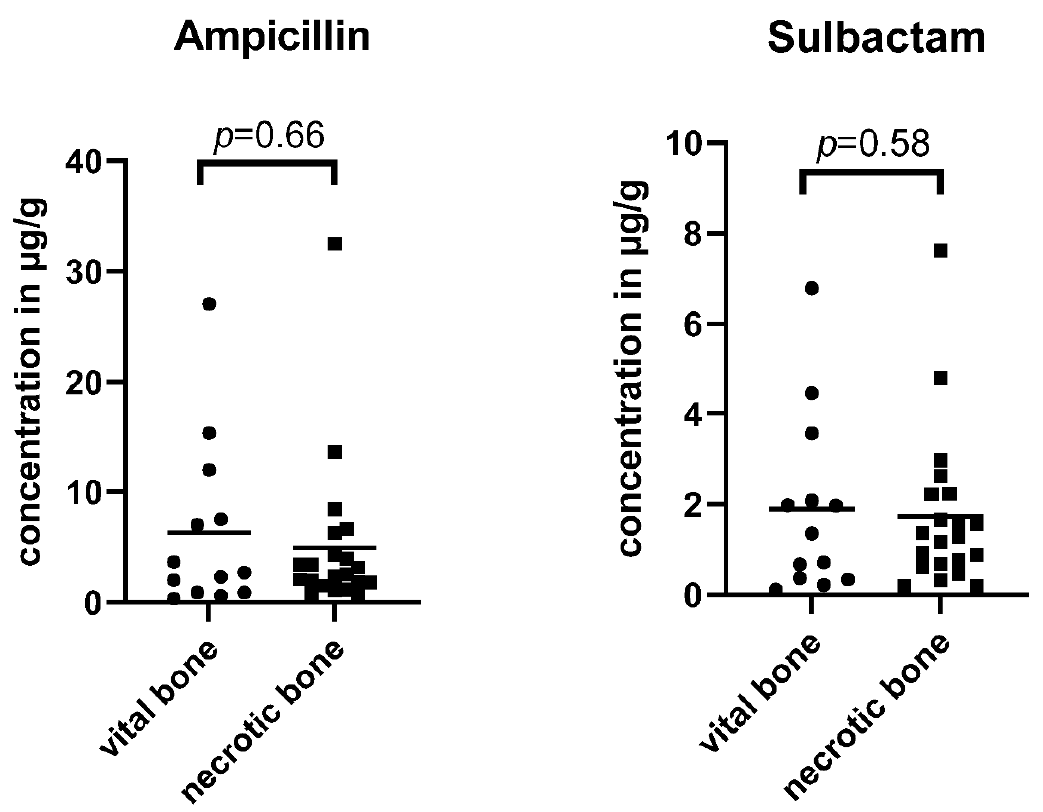
Figure 5. Ampicillin and sulbactam concentrations in vital and necrotic bone samples. For ampicil- lin, a mean concentration of 6.3 µg/g (SD ± 7.8 µg/g) in vital and 4.9 µg/g (SD ± 7.0 µg/g) in necrotic bone samples was detected. The values for sulbactam were 1.9 µg/g (SD ± 2.0 µg/g) in vital and 1.7 µg/g (SD ± 1.7 µg/g) in necrotic bone